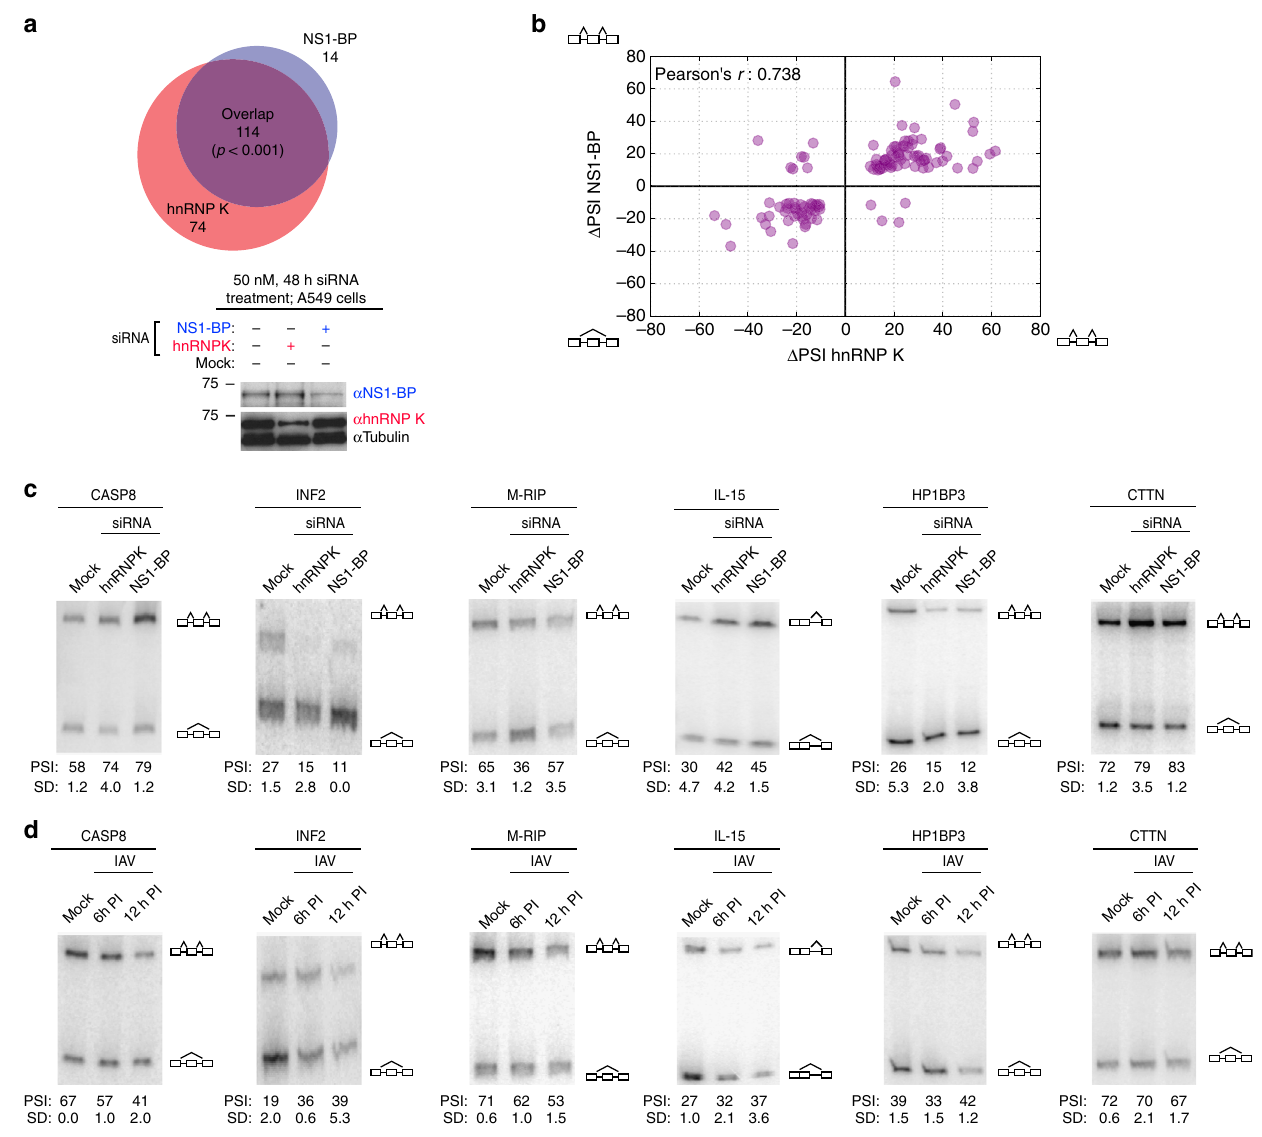
Fig. 6 hnRNP K and NS1-BP co-operatively regulate host alternative splicing events. A549 cells were mock transfected or treated with 50 nM siRNA targeted for hnRNP K or NS1-BP in triplicate. Total cell RNA was then extracted and subjected to RASL-seq. a Overlap of hnRNP K and NS1-BP responsive alternative splicing events with Δ PSI ≥ |10| and p < 0.05 (students t test). Overlap signi fi cance determined by Fisher ’ s exact test. Whole cell extracts were immunoblotted for hnRNP K and NS1-BP (and Tubulin loading control) to determine siRNA knockdown ef fi ciency. Molecular weights are indicated to left of each blot. b Correlation plot of Δ PSI values of alternative splicing events regulated by hnRNP K and NS1-BP (overlap in panel a ). Positive values indicate alternative exon inclusion and negative values indicate alternative exon skipping upon knockdown of hnRNP K or NS1-BP. c Representative validations of hnRNP K and NS1-BP-regulated alternative splicing events using low-cycle, radiolabeled RT-PCR visualized via PAGE. Quanti fi cation represent signal of upper inclusion product divided by total signal of upper inclusion product and lower exclusion product (complete list of validations in Supplementary Table 1). d Low-cycle, radiolabeled RT-PCR analysis of validated hnRNP K and NS1-BP regulated splicing events during IAV infection at moi = 2. PSI and SD represent 3 independent experiments. Uncropped gels shown in Supplementary Fig.